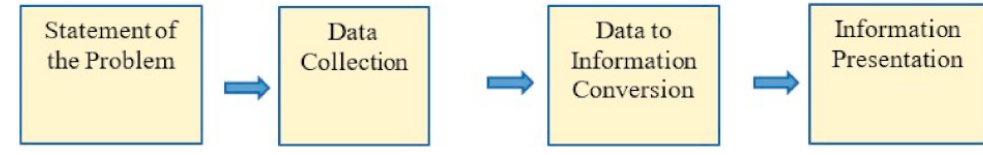
Figure 2. General remote sensing process